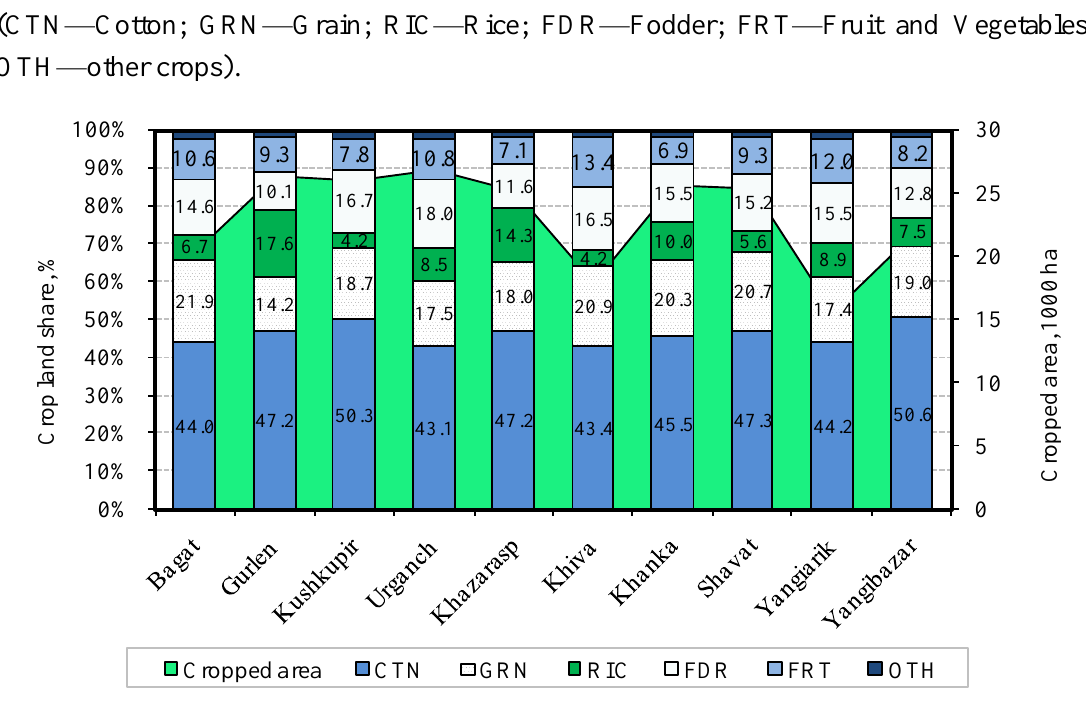
Figure 4. Cropland allocation across administrative districts, 2000−2007